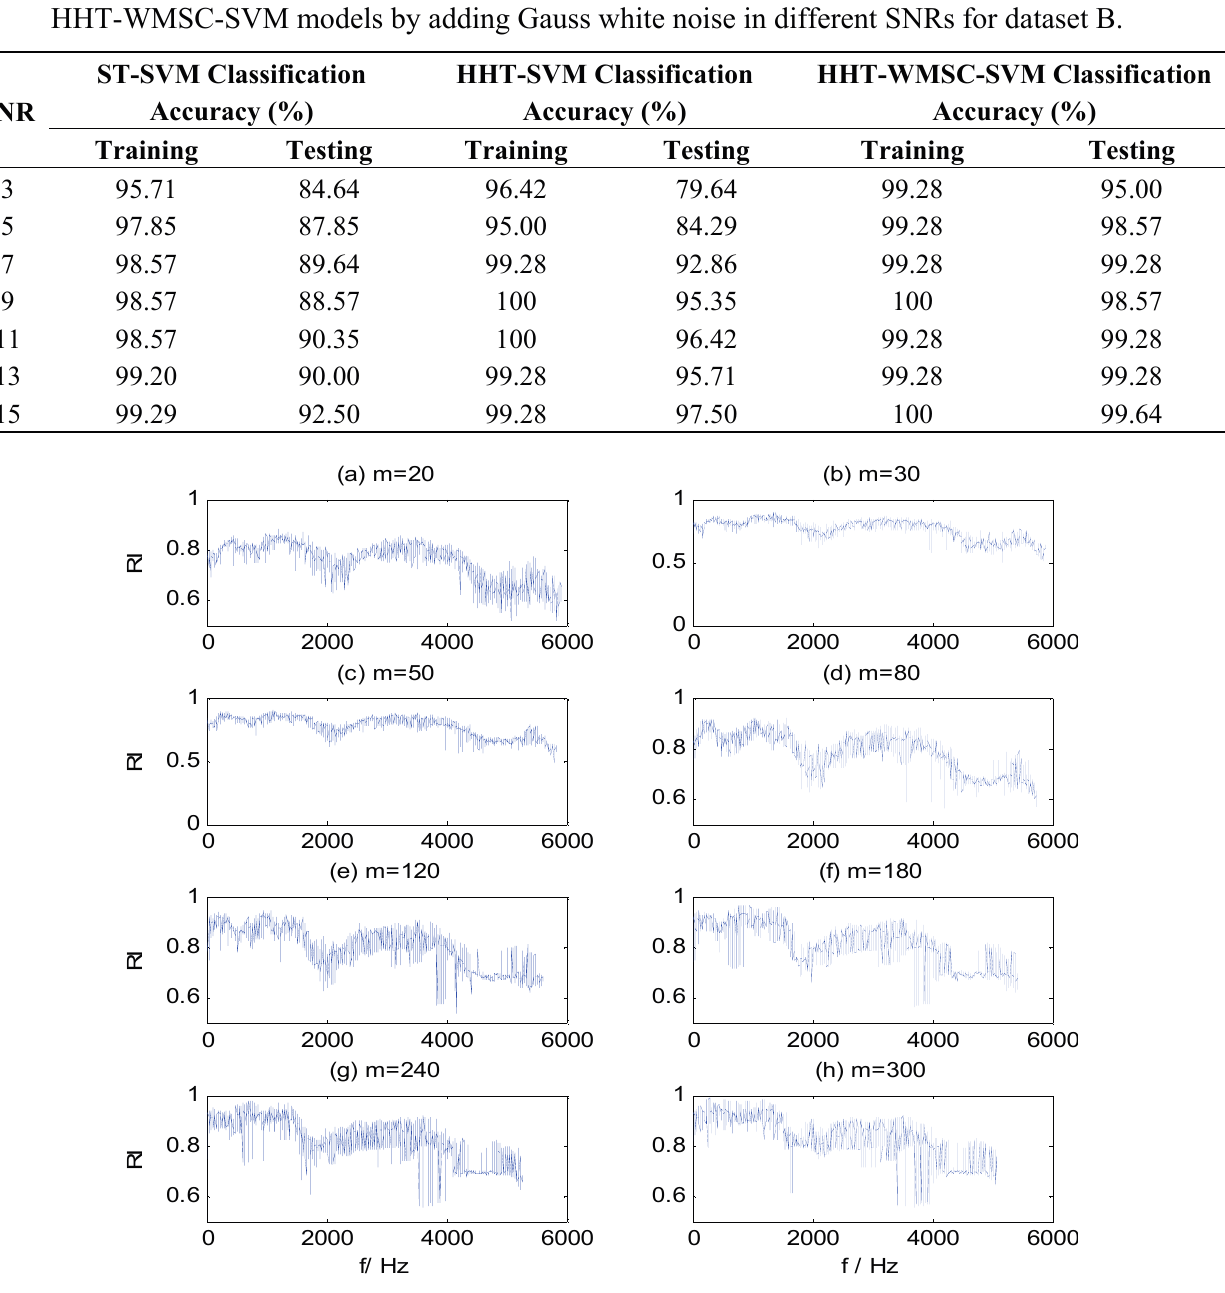
Table 7. Bearing fault detection results obtained by ST-SVM, HHT-SVM and